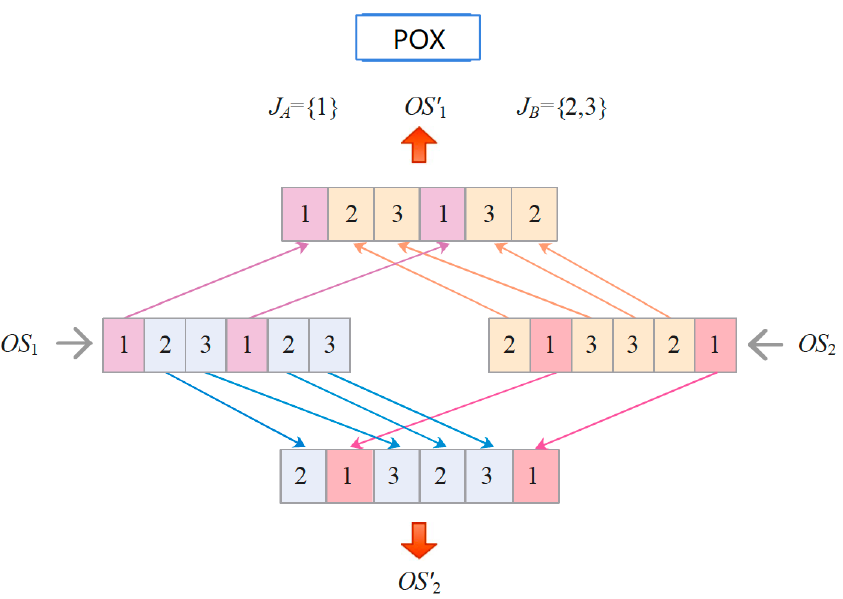
Figure 3. Example of a precedence operation crossover